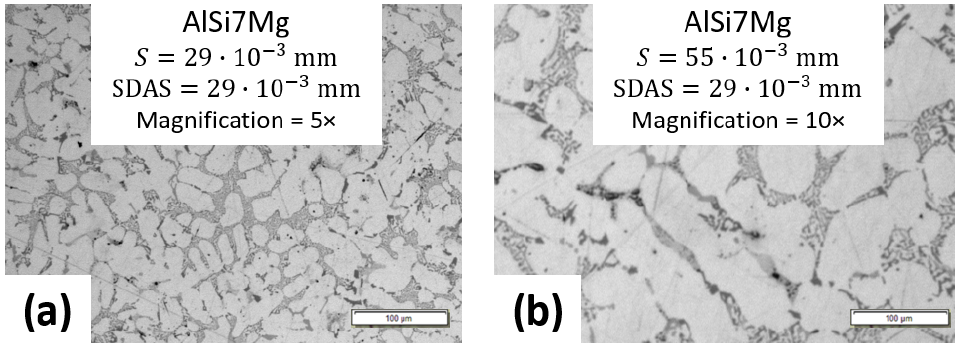
Table 2. The training set, validation set and test set were split in the ratio 60:20:20. The data instances were evenly distributed in terms of S values.